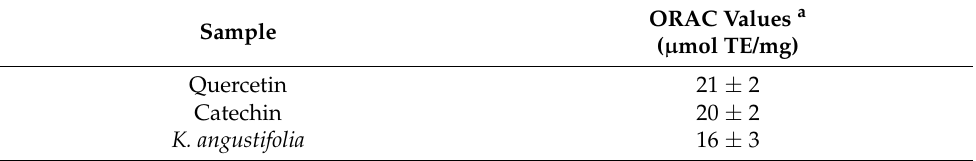
Table 1. Antioxidant activity as measured by an ORAC assay of the K. angustifolia extract. Data are presented as means of the triplicates ± S.D. All the experiments were carried out in triplicate and presented results are representative of at least two different experiments ( N = 2, n = 3). Quercetin and catechin were used as positive controls.